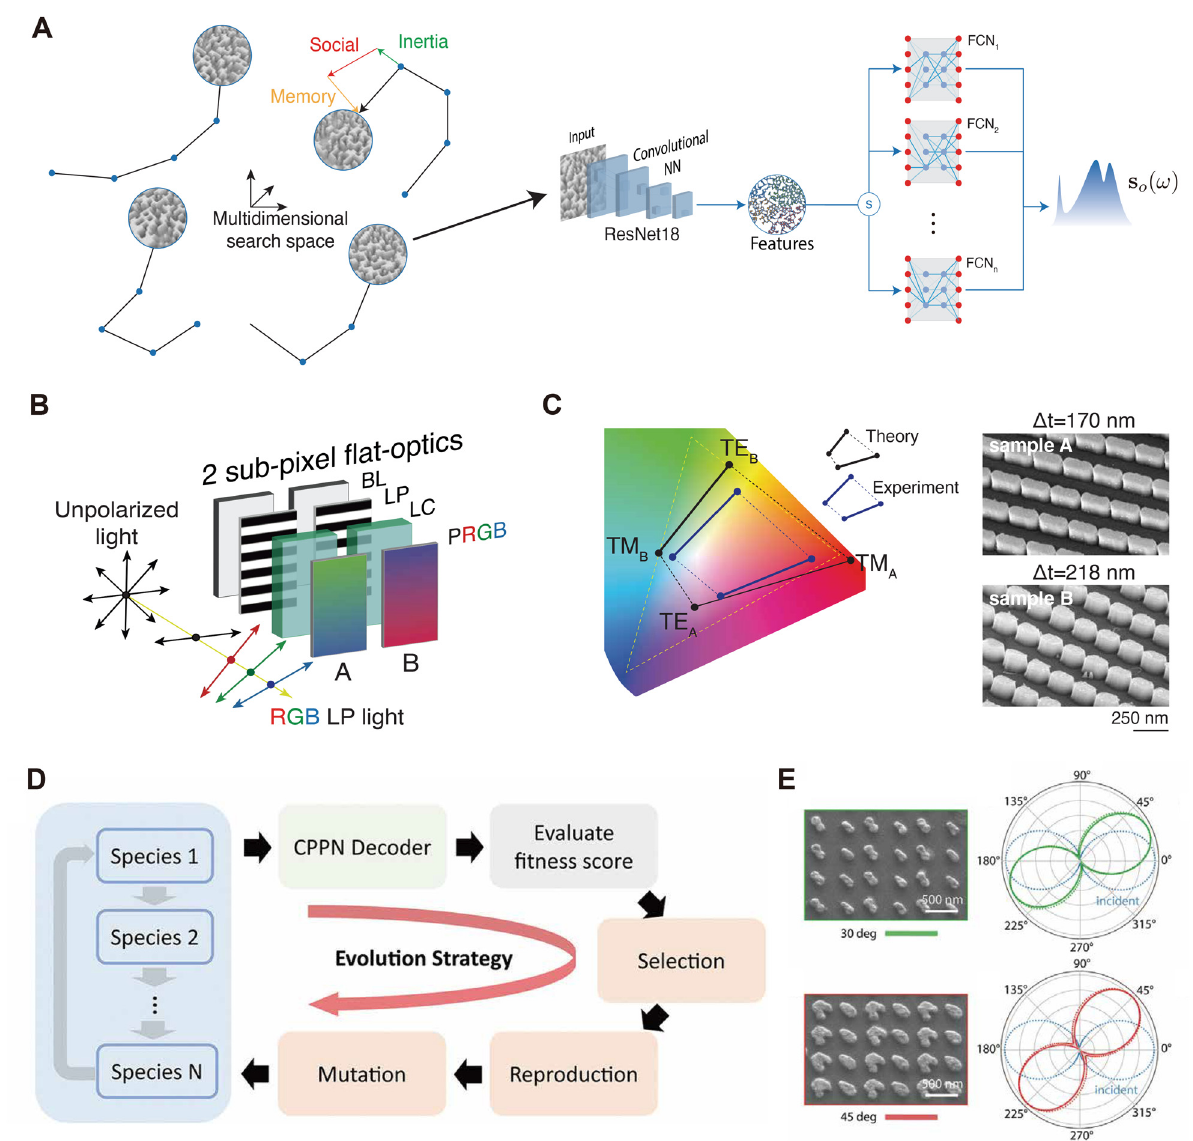
Figure 8: Hybrid design methods leveraging deep learning models as fast EM solver (A) An autonomous learning framework for rule-based evolutionary design, comprising a fast CNN predictor and a parallel PSO algorithm. (B) Generalized two-subpixel color display designed with a polarization-sensitive response, where backlight (BL), linear polarizer (LP), and liquid crystal (LC) layers alter the incident polarization to the flat-optics subpixels. (C) Left: chromaticity gamut of the subpixels in the color space. Right: SEM images of the fabricated subpixels. (A), (B) and (C) are adapted from [18]. (D) A hybrid system for the design of diatomic polarizers including cooperative coevolution algorithm and a pre-trained compositional pattern-producing network. (E) Left: SEM image of two optimized structure with rotation angles of 30 ◦ and 45 ◦ . Right: incident polarization (blue dash line), desired rotation angle (green/red solid line) and experimental results (green/red dash line). (D) and (E) are adapted from